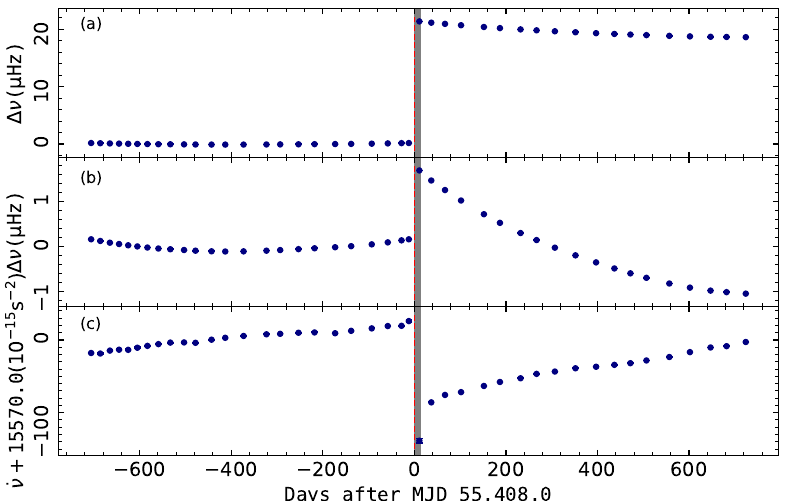
Figure 4. The PSR J0835–4510’s (Vela pulsar) July 2010 glitch with an exponential decay timescale of 13 ( 2 ) d (marked grey area) observed by the Fermi-LAT [30,101]: ( a ) the variations in spin frequency after subtracting the pre-glitch timing model; ( b ) expanded plot of ∆ ν where the mean post-glitch value has been subtracted from the post-glitch data; ( c ) the evolution of ˙ ν . The vertical line indicates this glitch epoch at MJD